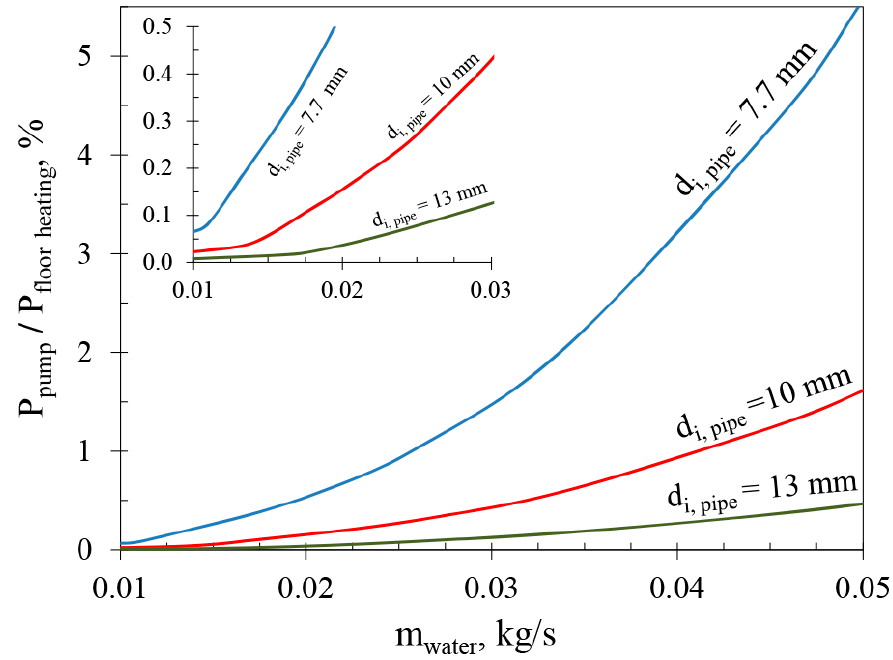
Figure 6. The variation of ratio between pumping power need and produced heat output with water flow rate in a floor heated room of 20 m 2 floor area. θ supp = 35 °C.